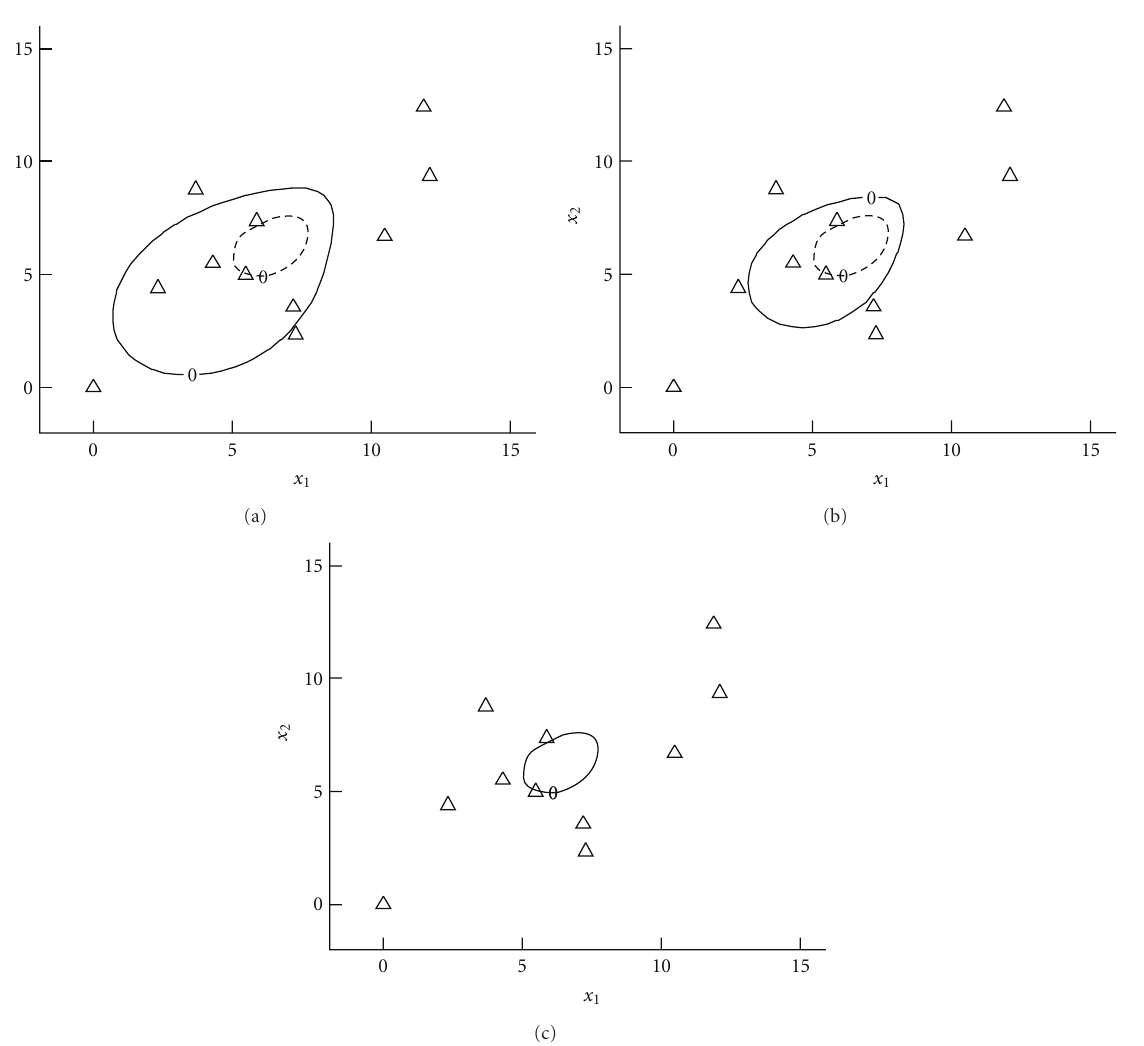
Figure 1: The contours f ( x , w ) = 0 by di ff erent values of η = 0, 0 . 5, 1 and by n =